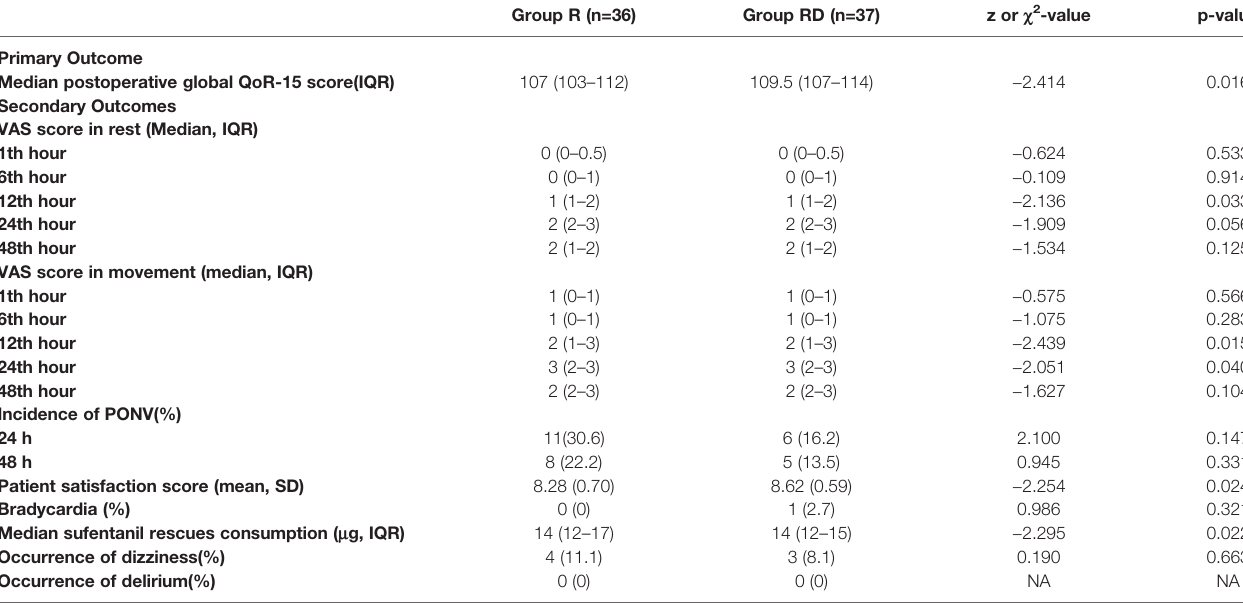
TABLE 2 | Outcomes for patients receiving deep serratus anterior plane block with ropivacaine or ropivacaine plus